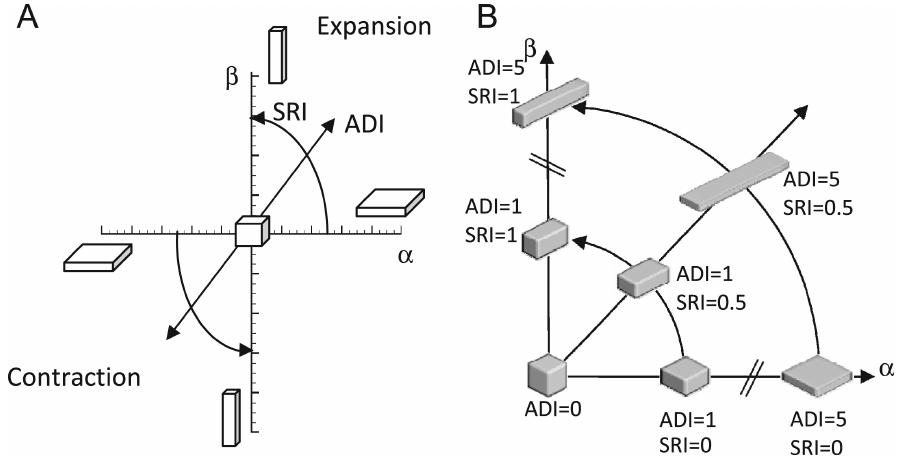
Figure 2. Illustration of regional shape change with respect to ADI and SRI. ( A ) shows the cuboid shape space as a function of ADI and SRI and how these values are related to α and β in terms similar to polar coordinates. The cuboid shape is a uniform cube when ADI = 0. The cuboid shape is flat when SRI = 0 and rod like when SRI = 1. The shape of a uniform cube expands or contracts as the magnitude of ADI increases. ( B ) shows the cuboid shape space for particular values of ADI and SRI. Figure from